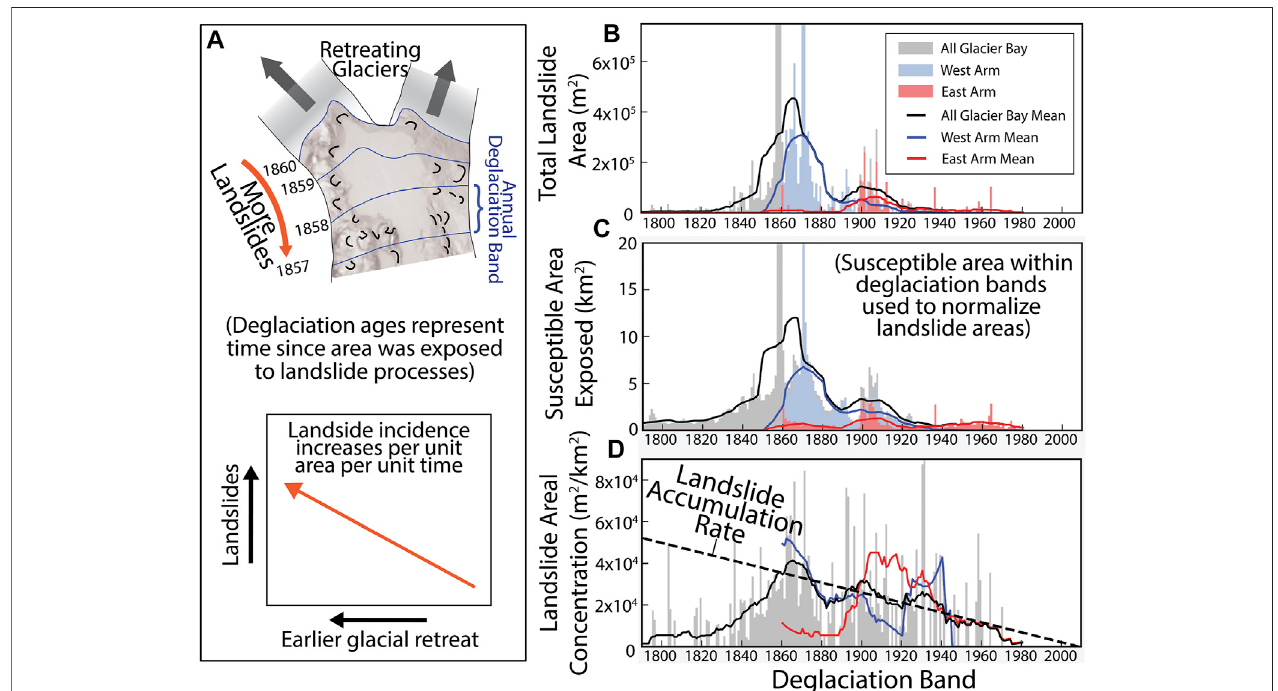
FIGURE 9 | (A) Conceptual diagram for the inventory-based landslide accumulation approach to determine susceptibility. Total landslide incidence varies as a functionofthetimingoftheinitialexposureofsubmarineslopes,resultinginameanincreaseinarealconcentrationofaccumulatedlandslideswithdeglaciationbandage. (B) Plot of total landslide area within each deglaciation band, shown for all of Glacier Bay, and the West and East Arms, individually. Data are expressed in raw form and with a 20-year moving-window mean (±10-year central window). (C) Plot of total susceptible (sediment-covered and > 2 ° slope angle) area exposed during each year of deglaciation (i.e., total susceptible area in each deglaciation band) for all of Glacier Bay and the West and East Arms individually. Plots B and C share a general distribution shape, whereby the larger a deglaciation band is, the more landslide area it hosts. (D) Plot of landslide areal concentration for all of Glacier Bay (raw and smoothed data), and for the West and East Arms, individually (smoothed data only), i.e., Plot B divided by Plot C. A positive correlation between landslide concentration and deglaciationagebetween1860and2009corroborates theconceptualmodelshownin (A) .Dashedblacklineshowsaleastsquareslinearregression(coef fi cientof determination ( R 2 ) = 0.82) to Glacier-Bay-wide mean areal landslide concentration for the period of 1860 – 2009, representing a landslide areal concentration accumulation rate of 238 m 2 km − 2 yr − 1 . For the susceptibility model, we did not fi t the accumulation trend to pre-1860 data because of the existence of broad areas of missing bathymetry in the South Bay (e.g., Figure 1 ), disparities in bathymetry collection years, and substantial differences in geomorphology between the South Bay and the Arms, which resulted in generally less susceptible terrain in the South Bay. The solid black line represents the mean spatial concentration (the one-dimensional meanofdatapresented in Figure3B ).Thelog-normalratiooflandslideconcentration(solidblackline)tolandslideaccumulation(dashedblackline)representsSI inventory values shown in the susceptibility map ( Figure 10B